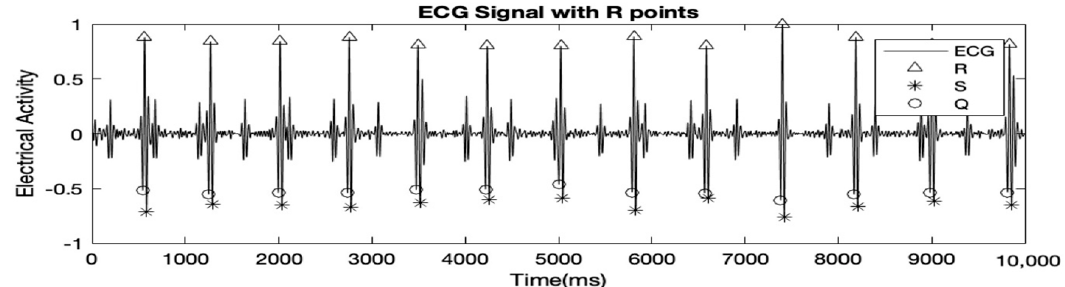
Figure 2. 10 s of the MAECG shown above with Q, R and S peaks detected.